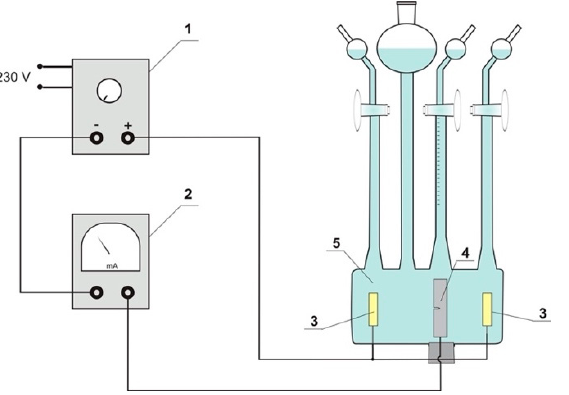
Figure 1. The hydrogenation in a Hoffman apparatus. 1—power supply, 2—amperemeter, 3— auxiliary electrode (platinum electrode), 4—analyzed aluminum alloy (cathode), and 5—electrolyte (0.1 N H 2 SO 4 solution).